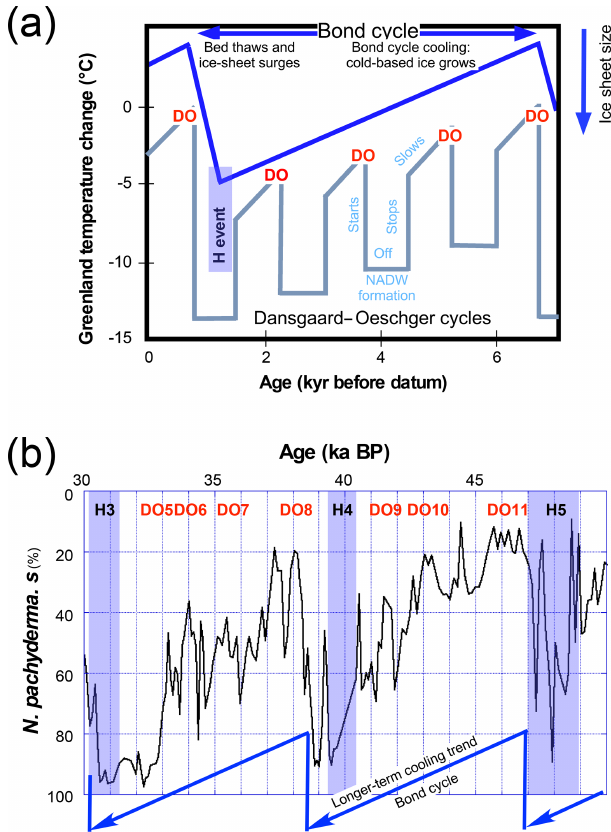
Figure 6. Description of a Bond cycle. (a) Idealized Bond cycle as illustrated following Alley (1998). DO stands for Dansgaard– Oeschger event, H event stands for Heinrich event, and NADW stands for North Atlantic Deep Water. (b) Variations in the percent- age of Neogloboquadrina pachyderma (s.), a species indicative of cold surface water, from DSDP 609 (Bond et al., 1992), illustrat- ing two Bond cycles. These cycles show a series of Dansgaard– Oeschger (DO) cycles composed of an abrupt warming that is fol- lowed by a return to glacial conditions represented by “stadials”. Every Bond cycle corresponds to a long-term cooling trend that starts with a strong warming and ends with a stadial that includes a massive iceberg discharge into the North Atlantic; Heinrich events are marked by a letter “H” followed by a number assigned by Bond et al.